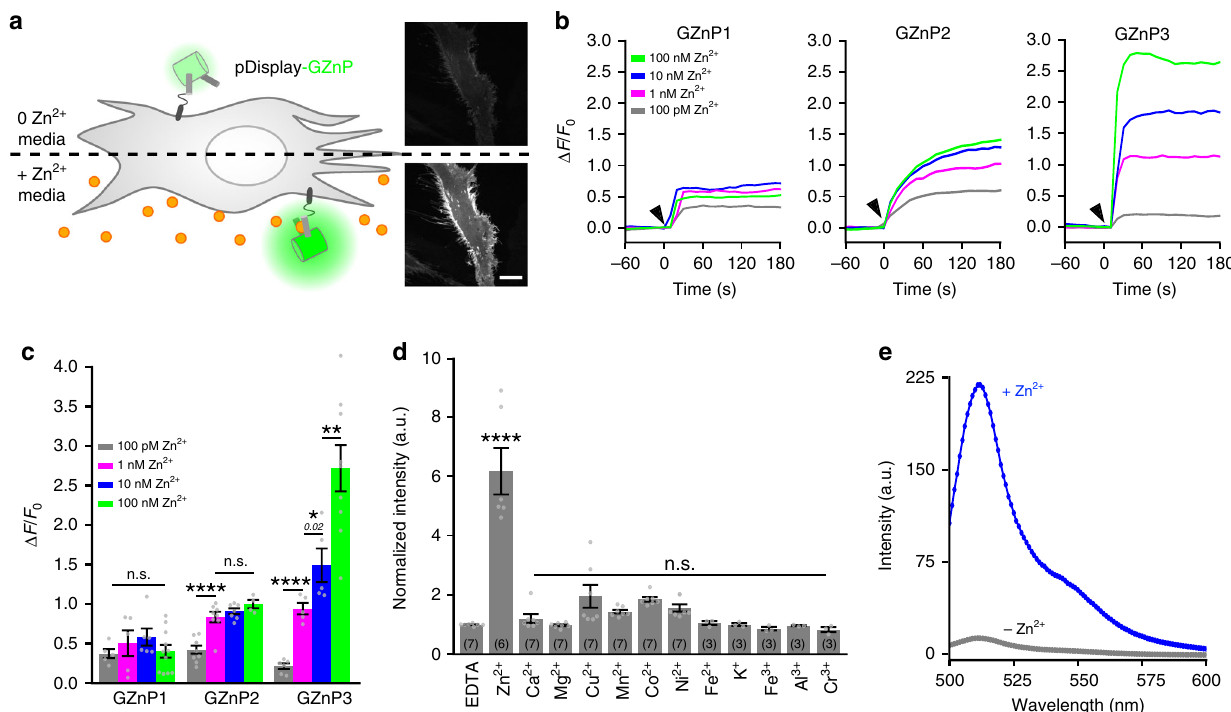
Fig. 1 GZnP3 sensor development and characterization. a Schematic of the pDisplay assay showing fl uorescence change of GZnP sensors in response to Zn 2 + (left). Representative micrographs illustrated the localization of GZnP3 sensor on extracellular face of plasma membrane in HeLa cells, where GZnP3 fl uorescence increased with Zn 2 + (right). Scale bar = 20 µ m. b Representative traces for each extracellular Zn 2 + concentration (gray, 100 pM; green, 1 nM; blue, 10 nM; red, 100 nM) for GZnP1, GZnP2, and GZnP3. Cells were pretreated with 100 µ M TPEN, washed, then imaged in the presence of 500 µ M TCEP. Buffered Zn 2 + solutions were added at 0sec (black arrow). c Mean Δ F/F 0 (±s.e.m.) at 60s for GZnP1, GZnP2, and GZnP3. GZnP1: 100 pM ( n = 5 cells), 1nM ( n = 5), 10 nM ( n = 6), 100 nM ( n = 11); GZnP2: 100 pM ( n = 9), 1 nM ( n = 8), 10 nM ( n = 7), 100 nM ( n = 4); GZnP3: 100 pM ( n = 6), 1 nM ( n = 5), 10 nM ( n = 5), 100 nM ( n = 9). Student ’ s one-tailed t -tests. d In vitro metal speci fi city of GZnP3 for Zn 2 + as compared to EDTA control (12 µ M), and a panel of biologically relevant divalent cations (50 µ M each in the presence of 12 µ M EDTA). Mean intensity± s.e.m. (n wells displayed on bars), normalized to EDTA control. One-way ANOVA, with Dunnett ’ s multiple comparison to EDTA control. e Representative in vitro emission spectrum of GZnP3 in the apo (gray) and the Zn 2 + saturated (blue) state when excited at 488 nm. GZnP3 displayed an emission peak at 512 nm and the peak fl uorescence